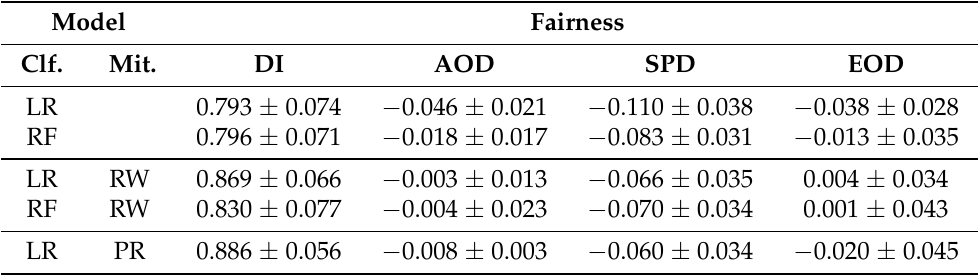
Table 5. Fairness metrics for logistic regression (LR) and random forest (RF) classifiers including bias mitigation strategies reweighing (RW) and prejudice remover (PR). The fairness metrics are disparate impact (DI), average odds difference (AOD), statistical parity difference (SPD), and equal opportunity difference (EOD). The errors shown are standard